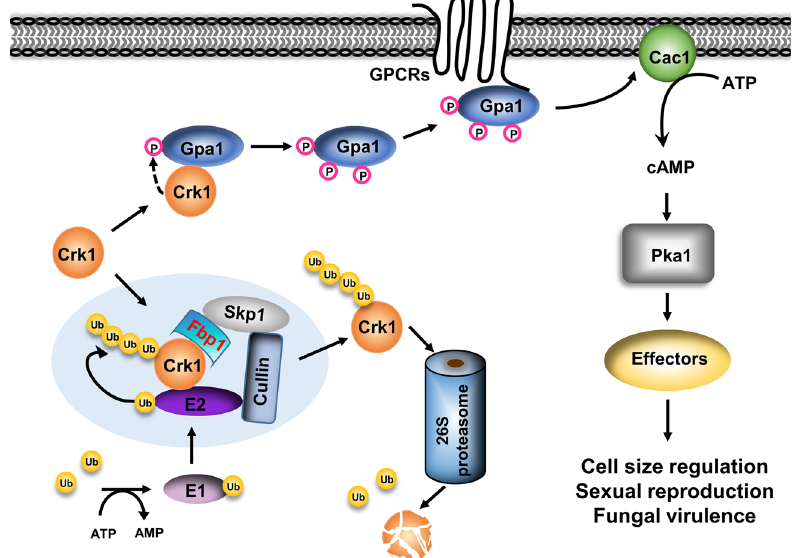
Fig. 6 | Proposed model for the involvement of Crk1 in the ubiquitin pathway and the G protein pathway. The SCF(Fbp1) E3 ligase interacts with Crk1 for its ubiquitination and degradation at the 26S proteasome. Overproduction of Crk1 under titan cell-inducing conditions promotes Gpa1 phosphorylation. The